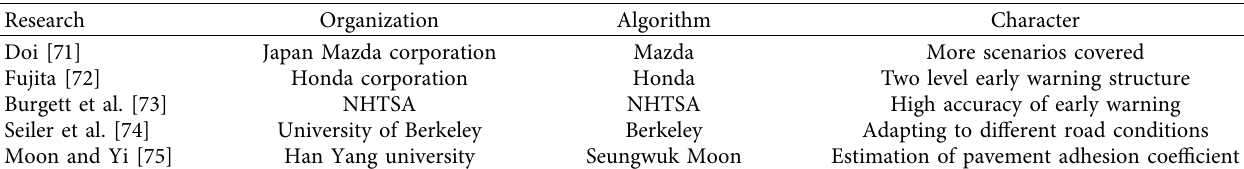
Table 1: Existing algorithms for the safety distance